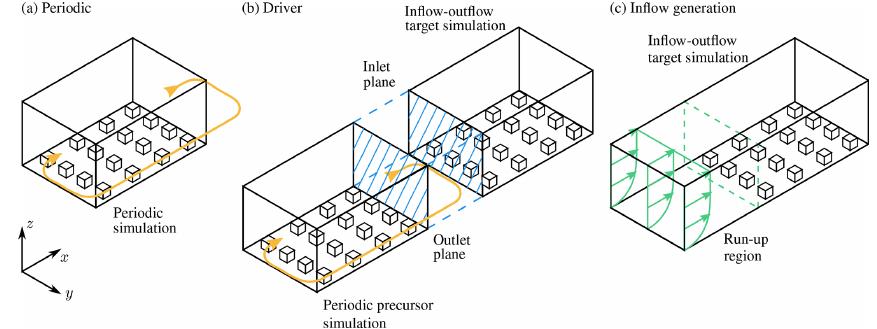
Figure 1. Diagrammatic view of the lateral boundary conditions available in uDALES. (a) Periodic simulation set-up, (b) precursor simula- tion set-up (composed of a periodic precursor simulation and a target simulation with inflow–outflow boundaries) and (c) inflow generation set-up (turbulent profiles generated numerically at the inlet and a run-up region in the streamwise direction to allow the flow to develop).